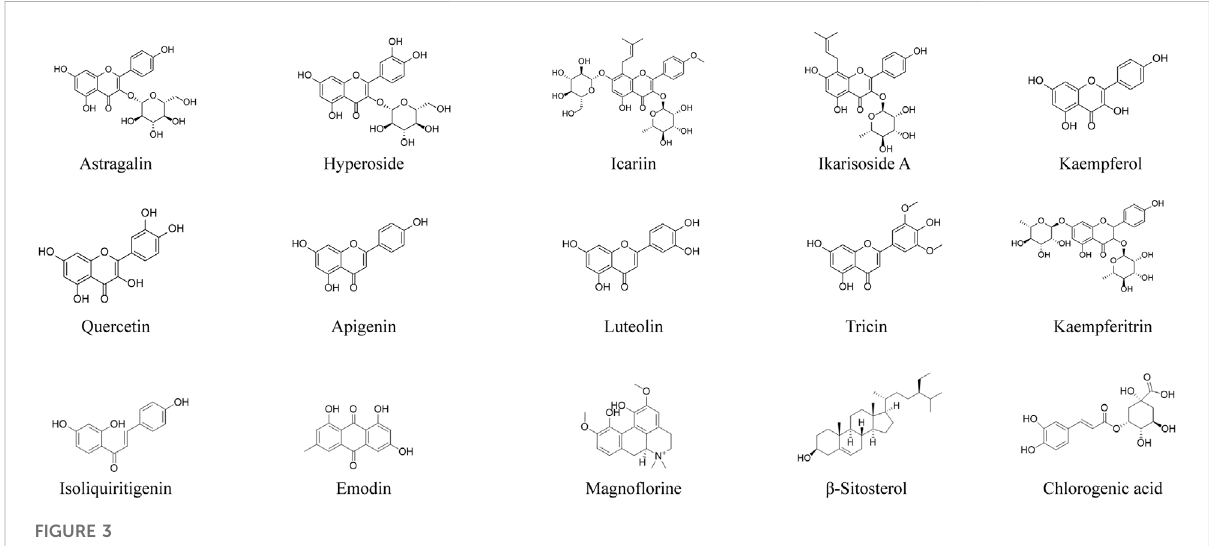
FIGURE 3 Structure of compounds from EH against